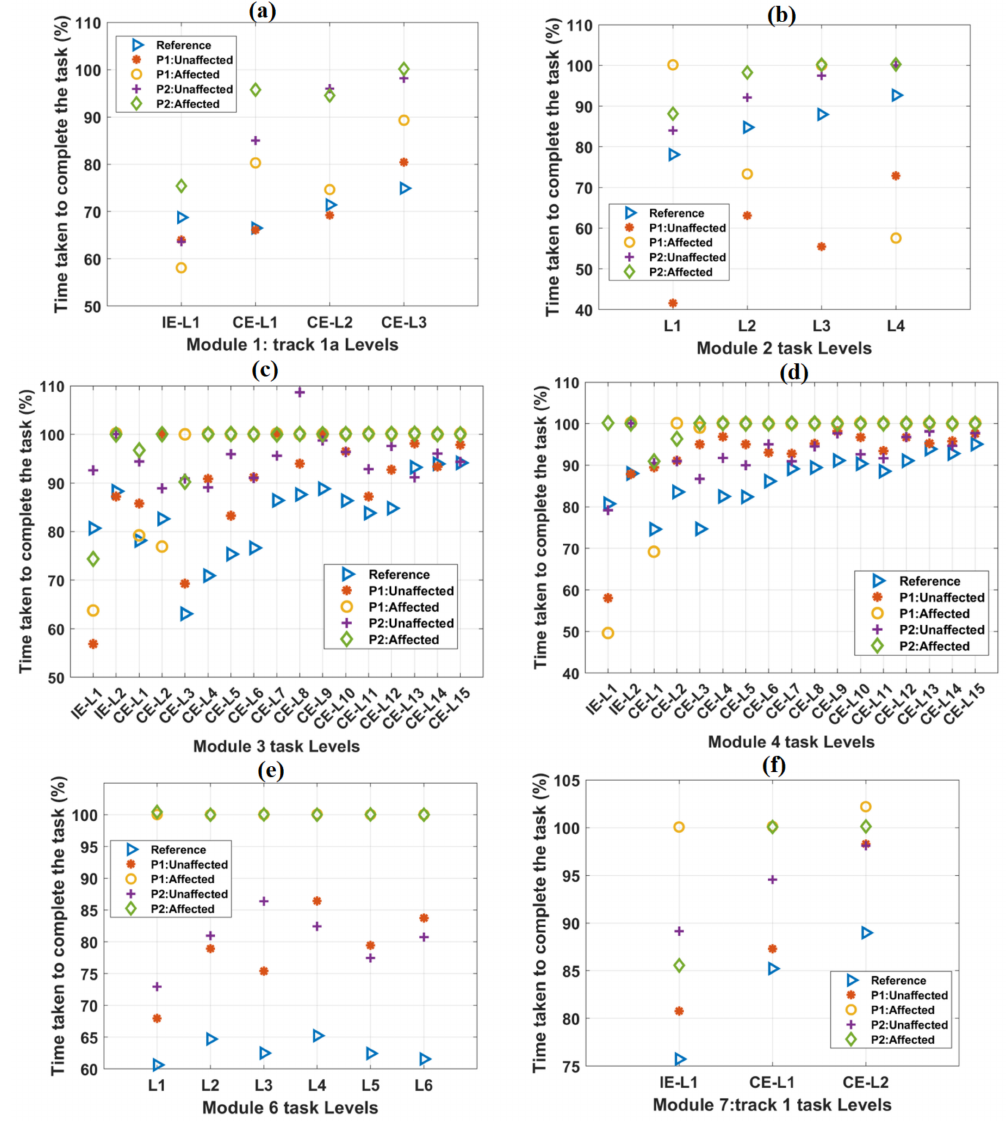
Figure 4. The variation of the TCT parameter with the increase in difficulty levels in ( a ) Module 1, ( b ) Module 2, ( c ) Module 3, ( d ) Module 4, ( e ) Module 6, and ( f ) Module 7 tasks. In each case, the scores of both the patients were plotted against the mean score obtained from forty healthy subjects, which was taken as a reference. In most of the cases, TCT scores obtained from the affected hands of both the patients were equal to